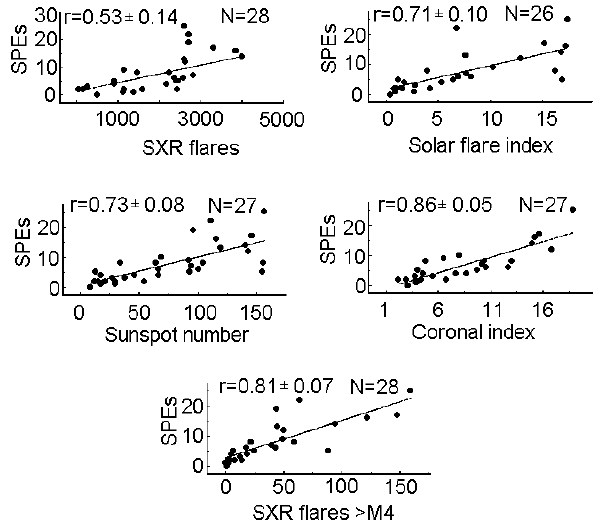
Fig. 4. Scatter plots and linear approximations of SPEs yearly num- ber dependences on the total SXR flares, sunspot number, solar flare index, coronal index and SXR flares with importance > M4.